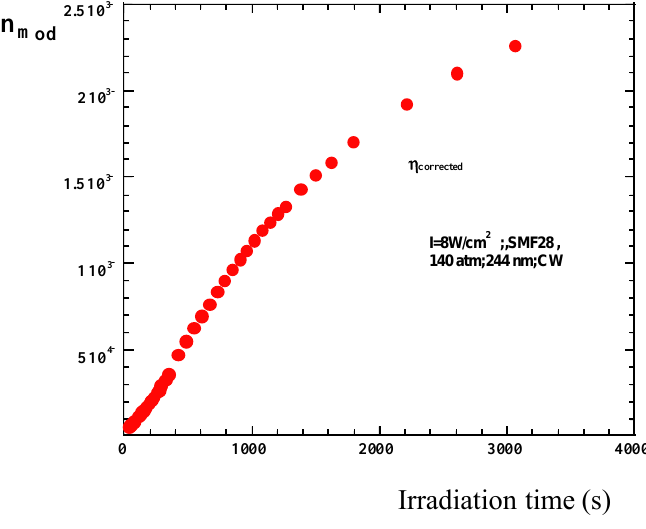
Figure 45. Index change in H 2 -loaded SMF28 (Corning) during writing with a CW 244 nm laser, reprinted with permission from [45]. Copyright 2001 University Lille